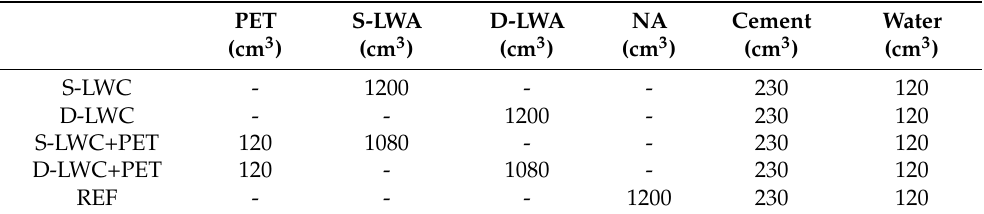
Figure 2. Lightweight concretes: ( a ) single lightweight concrete; ( b ) single lightweight concrete with PET; ( c ) double lightweight concrete; ( d ) double lightweight concrete with PET. Table 6. Mix design for a concrete sample. (Note: S-LWC: single lightweight concrete; D-LWC: double lightweight concrete; S-LWC+PET: single lightweight concrete with 10% addition of PET; D-LWC+PET: double lightweight concrete with 10% addition of PET; REF: reference sample with natural aggregates).